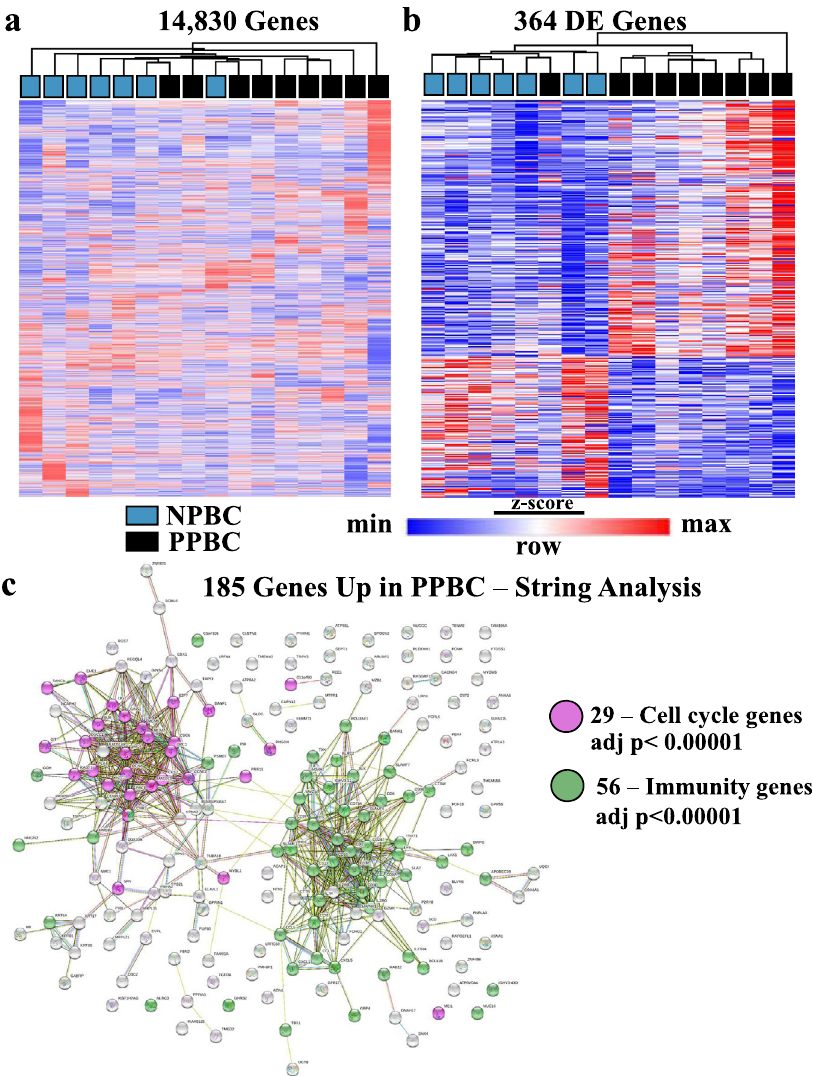
Fig. 1 RNA expression pro fi ling separates postpartum breast cancer (PPBC) from nulliparous breast cancer (NPBC). RNA seq, performed on RNA obtained from FFPE specimens of primary ER + breast cancer from patients 45 years of age or younger, reveals parity effect. Clustering analysis derived from RNA expression pro fi les of biologically independent samples of nulliparous breast cancer (NPBC, blue, n = 7) and postpartum breast cancer (PPBC, black, n = 9). a Euclidean hierarchical clustering of the 14,830 genes determined to be expressed above background. b Euclidean hierarchical clustering based upon 364 differentially expressed genes between PPBC and NPBC determined by DESeq2 with an FDR < 0.1. c STRING database clustering analysis 54 of 185 upregulated PPBC genes generates two distinct biological clusters of statistical signi fi cance (adj = adjusted. p values adjusted according to Benjamini – Hochberg for multiple